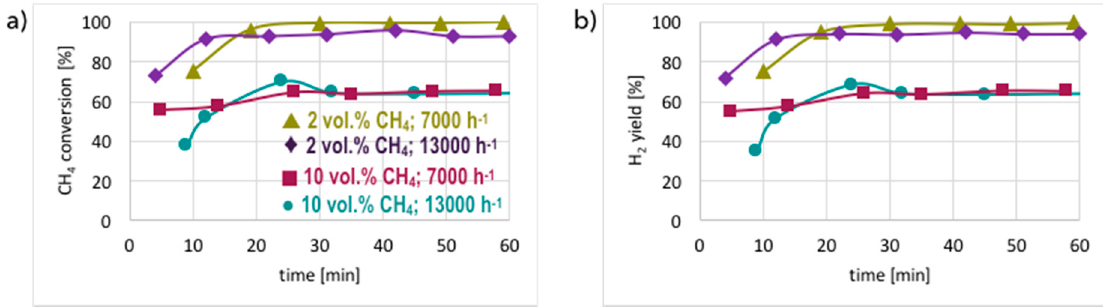
Table 1. Increase in Ni/CeZrO 2 mass after tests of CH 4 decomposition (T = 700 °C; t = 1 h). Catalyst